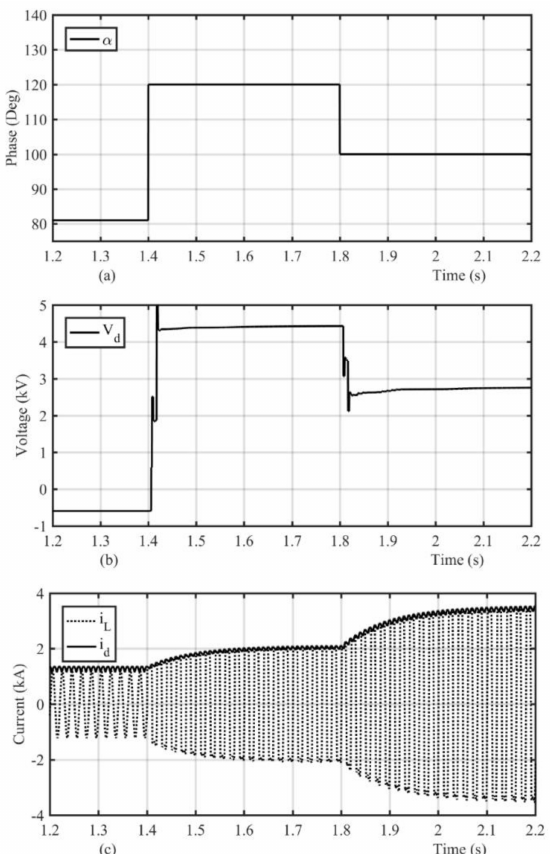
Figure 8. CDBFCL performance for two firing angles: ( a ) firing angle, ( b ) mean value of shunt bridge voltage, ( c ) fault